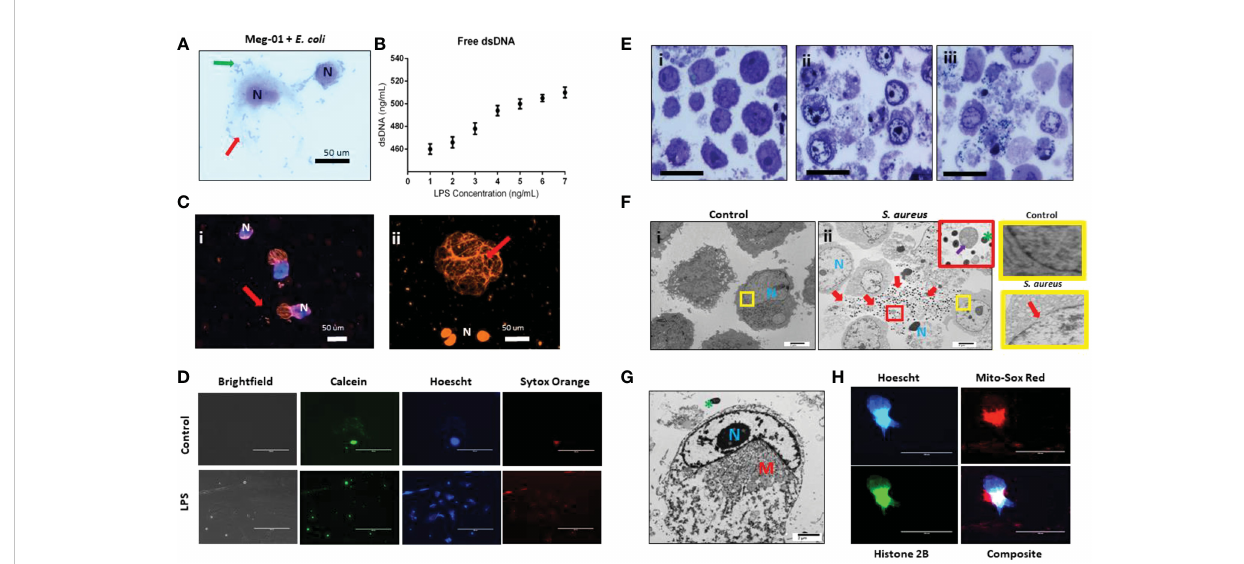
FIGURE 5 MK release chromatin webs. SC MKs and Meg-01 cells were observed to release chromatin webs in response to pathogenic stimulus. (A) Meg-01 cells co-incubated with live E. coli underwent cell lysis (diff-quick stain). Green arrow: bacteria; red arrow: extracellular cytoplasmic contents. (B) Chromatin released from Meg-01 cells after incubation with LPS quanti fi ed using PicoGreen assay. (C) SC MKs release chromatin webs after incubation with live pHrodo-conjugated E. coli . Live cell nuclei are blue (Hoechst stain). Chromatin webs are orange (Sytox stain). (Bi) SC MKS with nucleus (blue) and chromatin webs (orange). (Bii) SC MKs, one that has released a chromatin web (red arrow) and three dead cells with orange nuclei. (D) Meg-01 cells have intact cell membranes and proplatelet buddings (calcein staining). Cells incubated with LPS have scant calcein and abundant Sytox (extracellular chromatin) staining. (E) Meg-01 cells incubated with live bacteria display swollen nuclei, broken nuclear membranes, chromatin webs, extracellular granules, and bacteria associated with intra- and extracellular contents (light microscopy). (Ei) is the control, and (Eii – iii) are co-incubated with E. coli and S. aureus , respectively. (Fi) Transmission electron microscopy (TEM) of Meg-01 cells in media (control) revealed an intact nuclear membrane and limited extracellular content. Meg-01 cells co-incubated with live bacteria (Fii) display swollen nuclei (N), broken nuclear membranes, extracellular cytoplasmic contents (including granules and mitochondria), and an abundance of bacteria primarily associated with this extracellular content (red arrows). The red magni fi ed section in (Fii) demonstrates the presence of extracellular mitochondria (purple arrow) and the yellow magni fi ed sections on the right demonstrate an intact nuclear membrane in a control cell (top right) and a cell co-incubated with bacteria that has a break in the nuclear membrane (bottom right). (G) TEM image of a Meg-01 cell co-incubated with live E. coli exhibiting a swollen nucleus and a rearrangement of mitochondria surrounding the nucleus. (H) Meg-01 cells transfected with Bacmam H2b-GFP released chromatin webs that were both positive for DNA (Hoechst) and histone 2B. Mitochondrial staining with MitoSox red shows active mitochondria in a perinuclear arrangement, con fi rming the TEM fi ndings from panel (G)